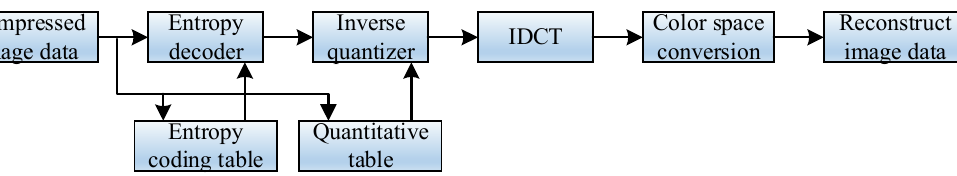
Figure 10. Image coding hidden block diagram.